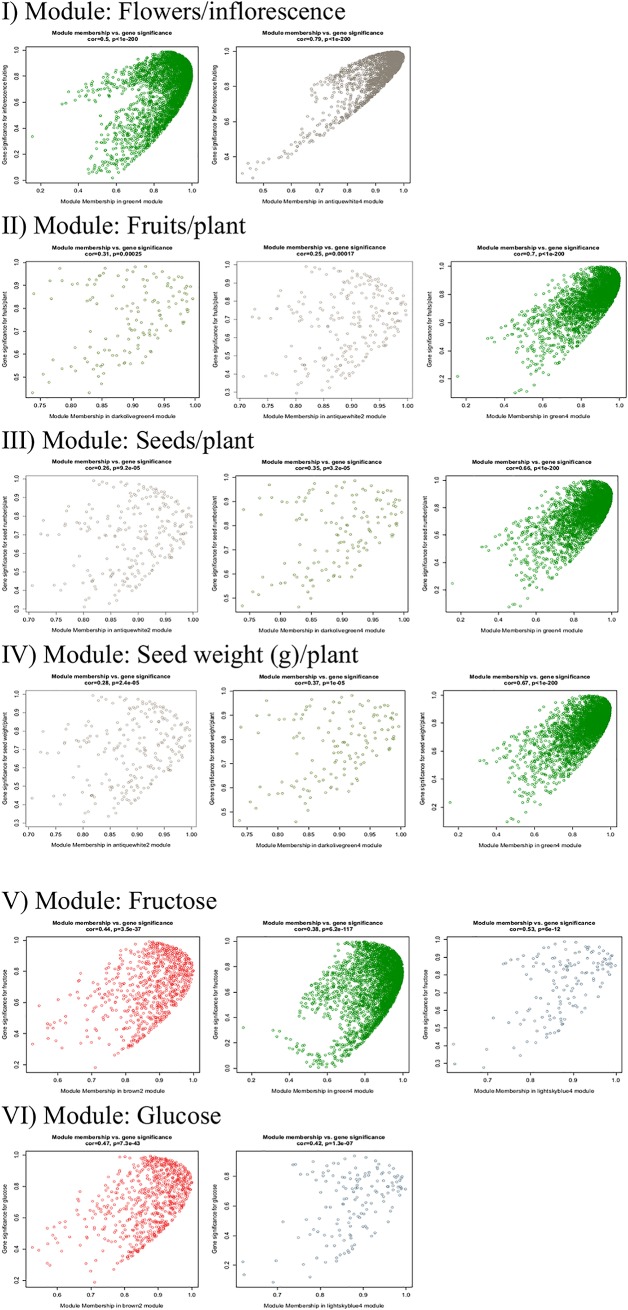
Gene significance (GS)-module membership (MM) of Jatropha curcas.Modules are obtained from hierarchical clustering of transcriptome data (inflorescence) and the GS-MM correlation (cor) is calculated using the weighted gene co-expression network analysis (WGCNA). Each trait and the putatively corresponding modules (in parentheses) are listed as following: I), flowers per inflorescence (antiquewhite4 and green4); II), fruits per plant (antiquewhite2, darkolivegreen4 and green4); III), seeds per plant (antiquewhite2, darkolivegreen4 and green4); IV), seed weight per plant (antiquewhite2, darkolivegreen4 and green4); V), fructose (brown2, green4 and lightskyblue4) and VI), glucose (brown2 and lightskyblue4).